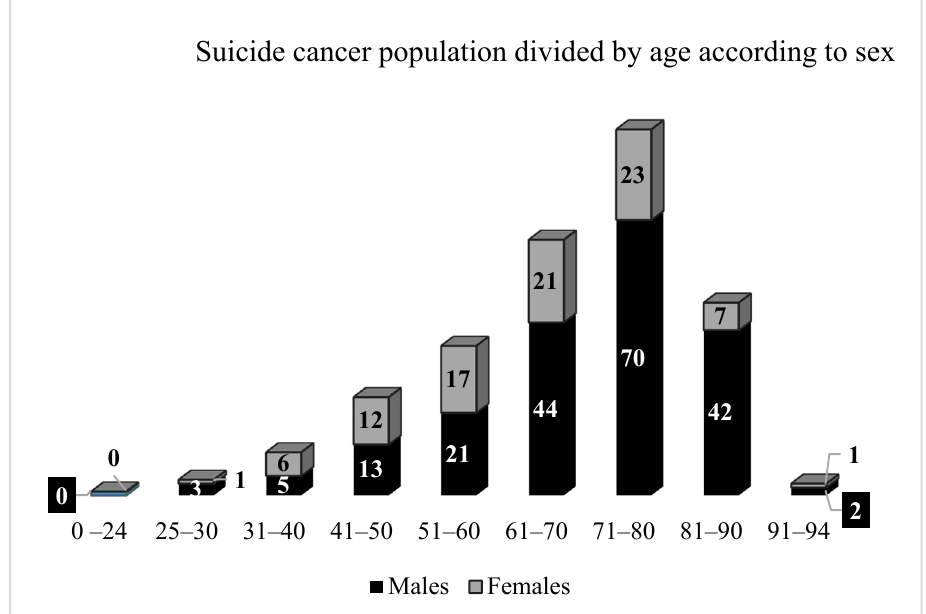
Figure 1. Graphic representation of the subjects died by suicide affected with cancer divided by sex and age decades.